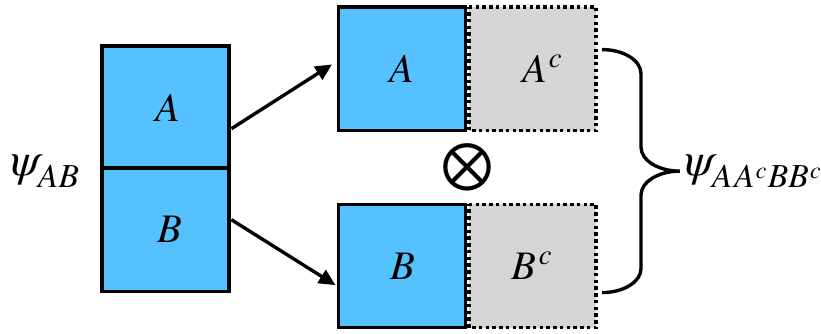
Figure 11 . Illustration of the optimal puri(cid:12)cation of two mixed states in two complementary subsystems A and B of an original pure state j (cid:9) i . The state in the subsystem A is puri(cid:12)ed by a AB state j (cid:9) i and the one in the subsystem B is puri(cid:12)ed by j (cid:9) i . Even though the direct product AA c BB c of the purifying systems j (cid:9) i (cid:10) j (cid:9) i generally has a larger number of degrees of freedom than AA c BB c the original state j (cid:9) i , the mutual complexity eq. (4.30) can have either AB